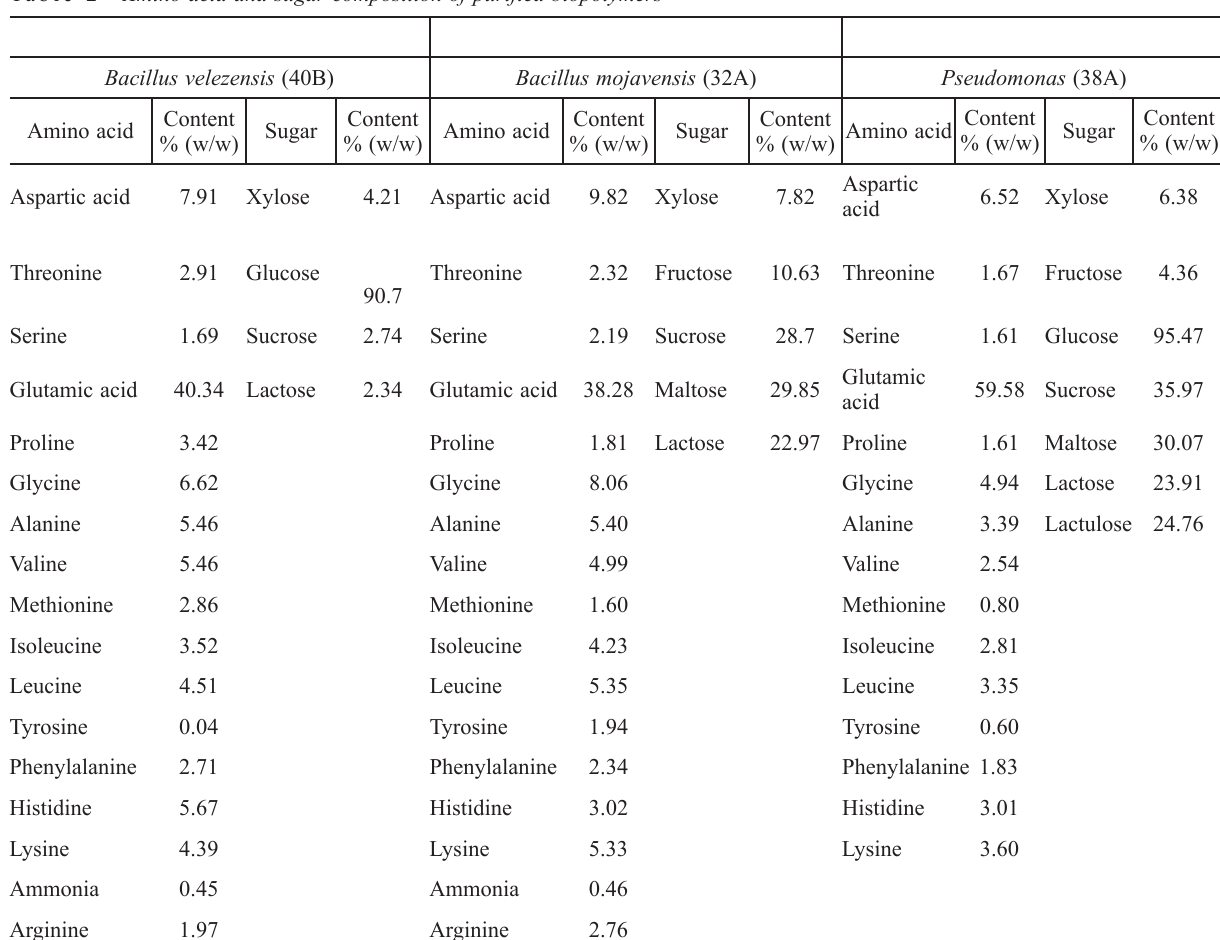
Table 2 – Amino acid and sugar composition of purified biopolymers